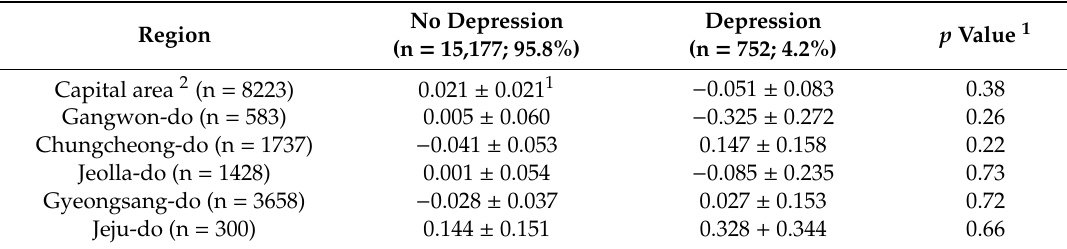
Table 3. Mean energy-adjusted dietary inflammatory index (E-DII) scores between study participants with or without depression.